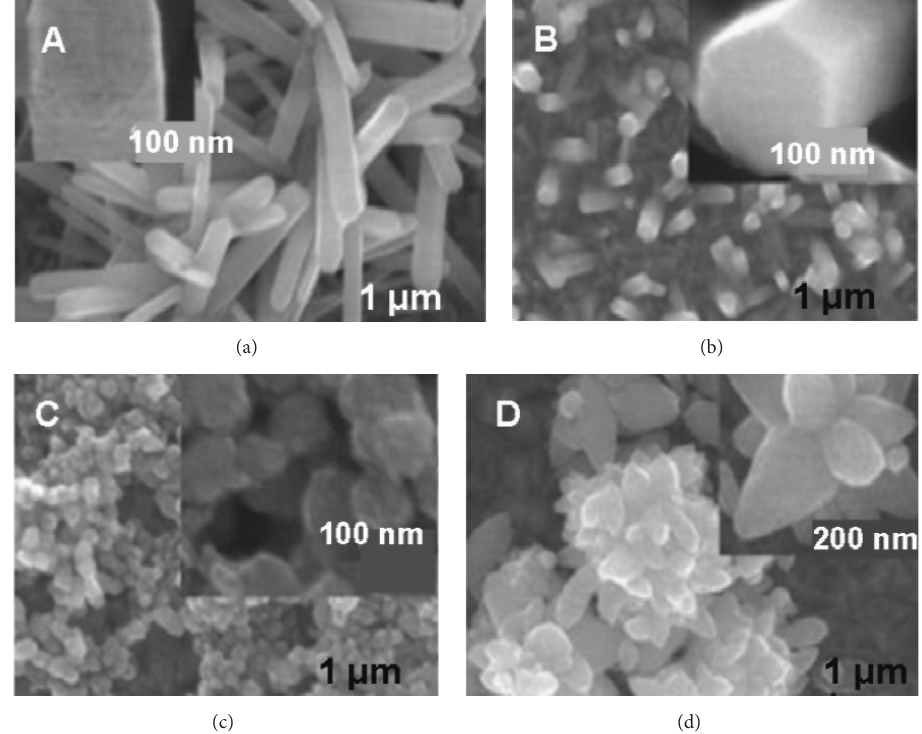
Figure 7: FESEM images showing the nanostructures obtained when growth was carried out at basic pH using 10mM reaction bath and growth duration of 5 hours (a) pH of 7.3, (b) pH of 8, (c) pH of 10, and (d) pH of 12 (reproduced with the permission from [54]).